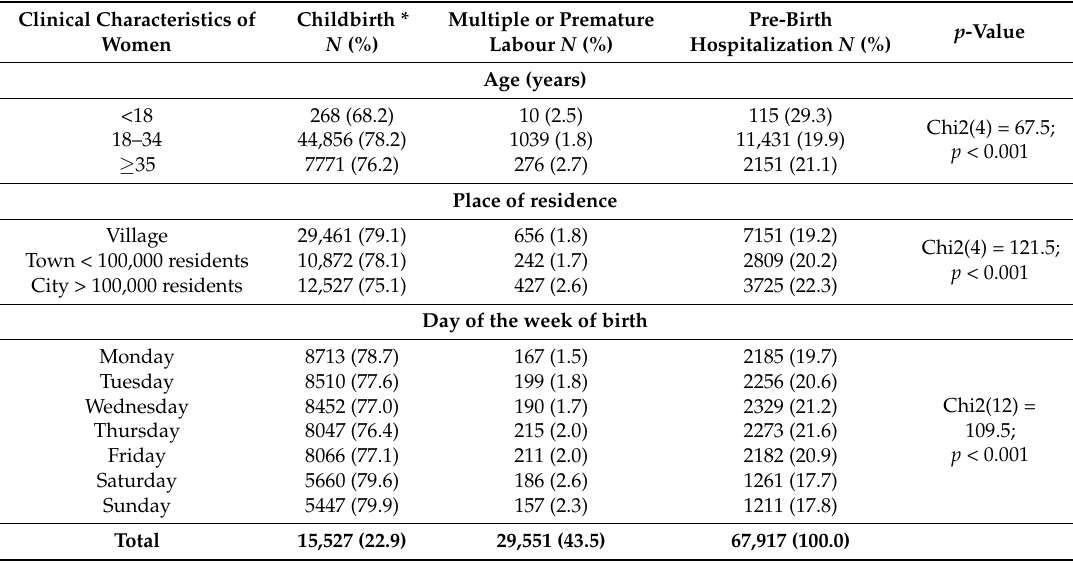
Table 3. Mode of admission for the birth in women giving birth in the years 2013–2014 in Malopolska. Clinical Characteristics of Women